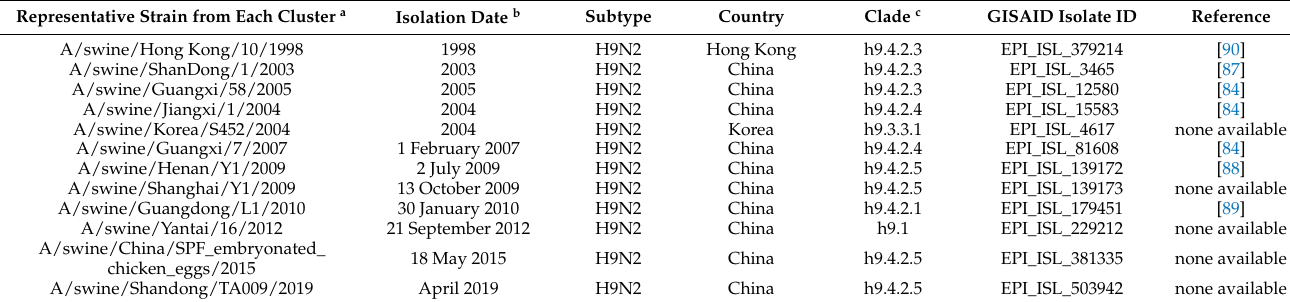
Table 3. H9 IAV-S isolated in Asian countries.